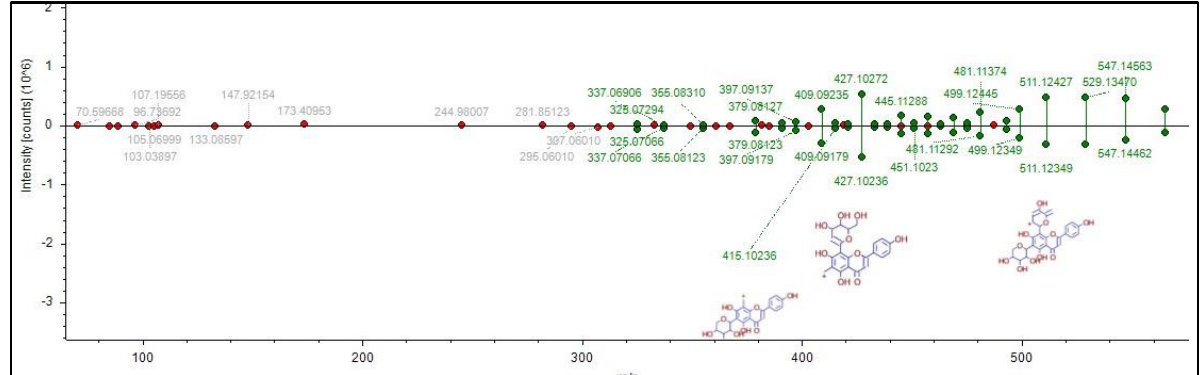
Figure 5. Mirror match of fragmentation of 2 with isoschaftoside by mzCloud spectral library.